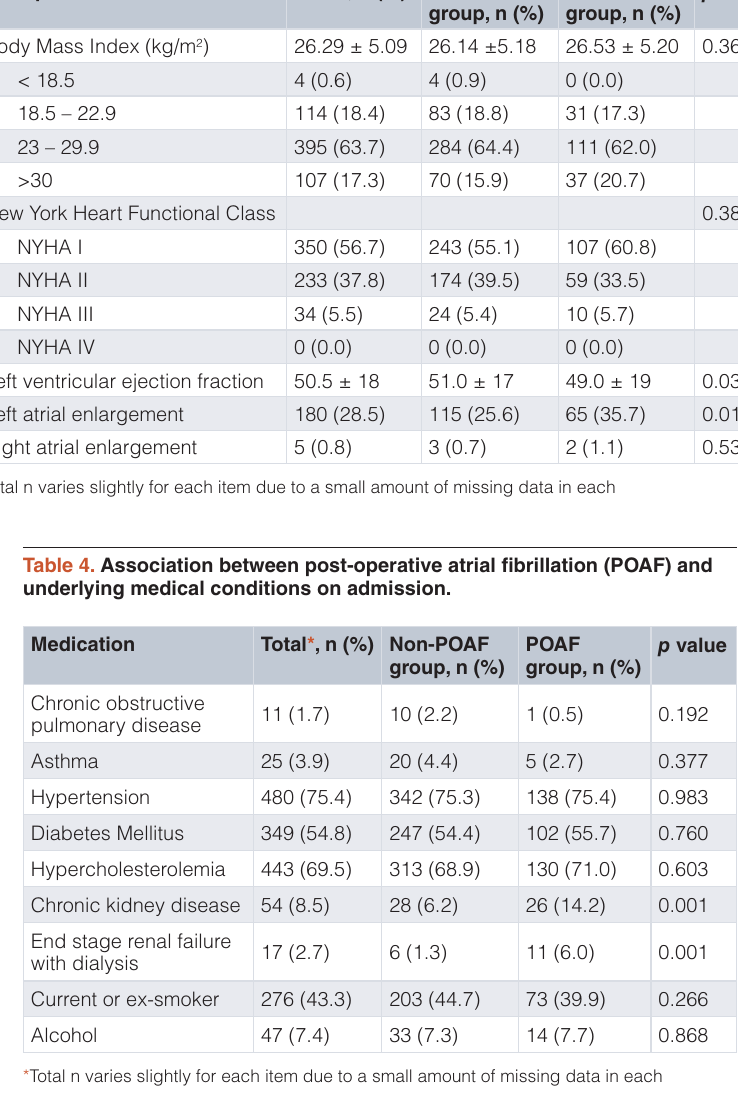
Table 3. Association between post-operative atrial fibrillation (POAF) and pre- operative characteristics that were recorded. Pre-operative characteristic